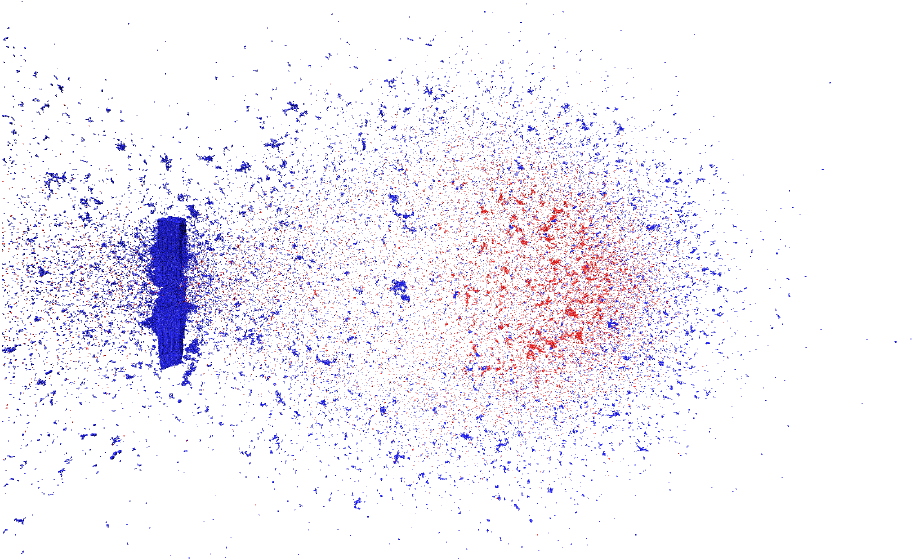
Figure 11. A snapshots of the resulting 3D simulation using the best fit parameters: ε = 0.01, κ = 4.56 × 10 6 and r cut = 1.5 σ . This simulation corresponds to the experiment shown in Figure 6. Impactor particles are in red and target particles in